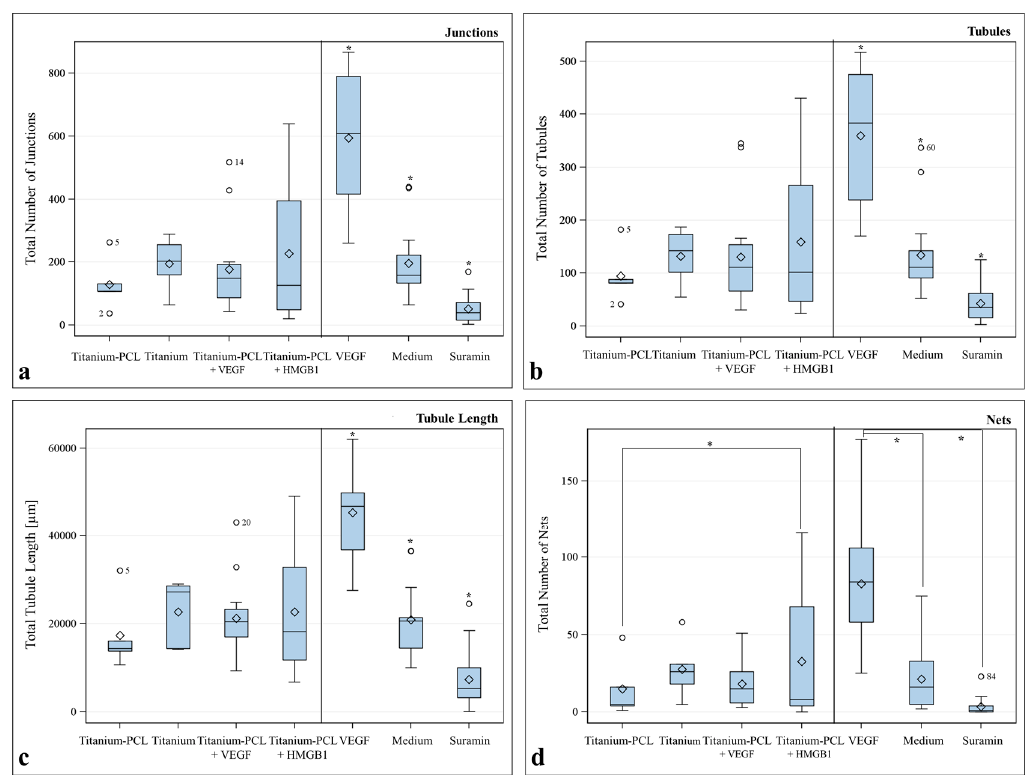
Figure 10. Results of the angiogenesis assay with titanium implants coated with poly- ε -caprolactone (PCL), pure titanium implants, titanium implant coated with PCL functionalized with Vascular Endothelial Growth Factor (VEGF) and High Mobility Group Box 1 (HMGB1) for ( a ) Number of Junctions; ( b ) Number of Tubules; ( c ) Total Tubule Length (µm); ( d ) Number of Nets. F -test from the analyses of variance followed by pairwise multiple means comparisons with the Least Significant Difference test were used ( * = p ≤ 0.05; circle = outlier; rhombus = mean; centered line = median).